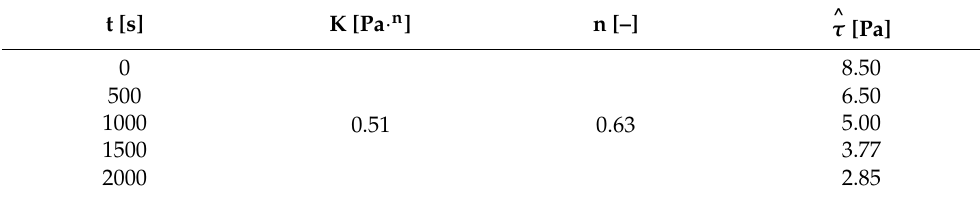
Table 3. Herschel–Bulkley parameters for the foam at different aging times